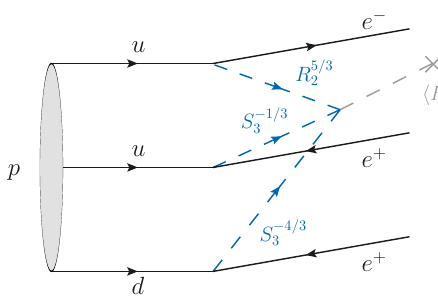
Figure 2 . Tree-level diagram contributing to the process p → e + e + e − in scenario ( d ) defined in table